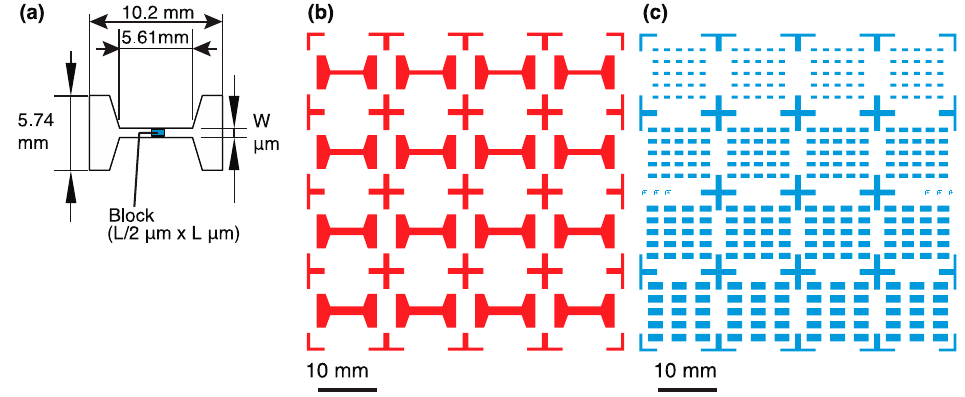
Figure 3. Design of a block and chamber for the actuation experiment by Volvox . ( a )